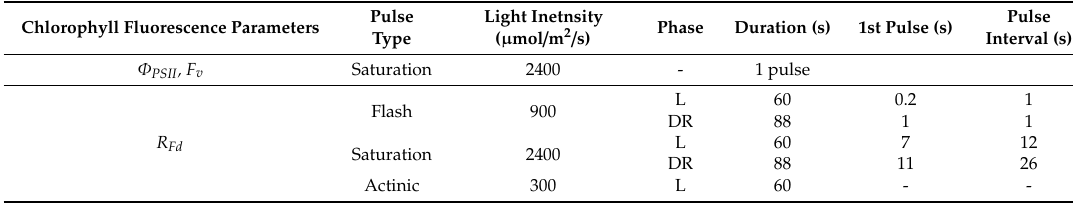
Table 2. Measurement protocol of the chlorophyll